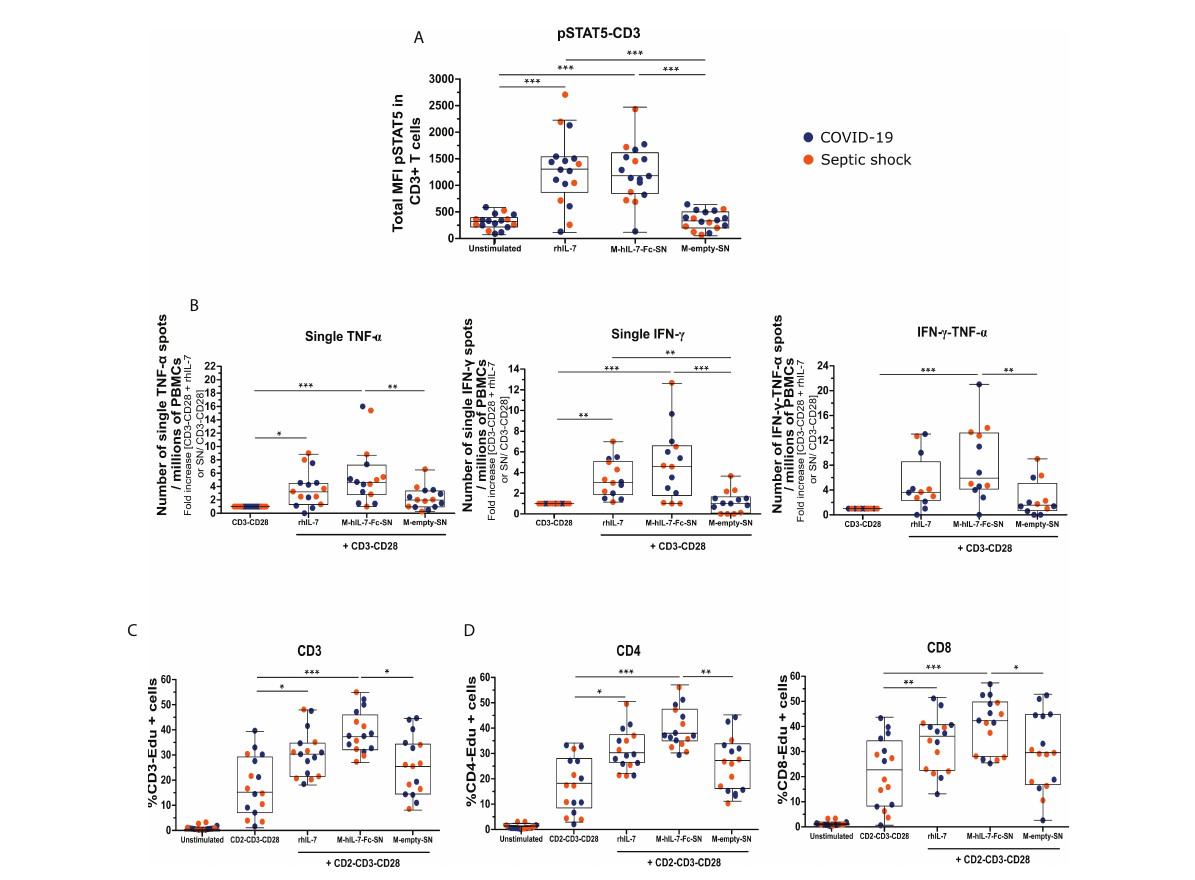
FIGURE 3 The MVA-secreted hIL-7-Fc restores ex vivo T lymphocyte function of patients with septic shock and COVID-19 at day 3 or 4 after ICU admission. (A) Total median of fl uorescence (MFI) of pSTAT5 in CD3+ T cells measured by fl ow cytometry. Whole blood cells of patients with septic shock (n = 6) and COVID-19 (n = 11) were stimulated for 10 min with diluted supernatant from MVA-hIL-7-Fc (M-hIL-7-Fc-SN) and empty MVA (M-empty-SN) infection and rhIL-7 at 100 ng/ml as positive control. (B) Number of single – TNF- a , single – IFN- g , and double – IFN- g – TNF- a spots per millions of PBMCs. PBMCs of patients with septic shock (n = 7) and COVID-19 (n = 8) were stimulated overnight with anti-CD3 and anti-CD28 antibodies (basal condition of cytokine production) in addition to M-hIL-7-Fc-SN or M-empty-SN or rhIL-7 at 100 ng/ml. Number of spots were normalized using the basal condition. Percentage of Edu+ CD3+ T cells (C) and of Edu+ CD4+ or Edu+ CD8+ T cells (D) , measured by fl ow cytometry. PBMCs of patients with septic shock (n = 7) and COVID-19 (n = 9) were stimulated for 3 days using anti – CD2-CD3-CD28 antibody – coated beads (ratio 1:1) in addition to M-hIL-7-Fc-SN or M-empty-SN or rhIL-7 at 100 ng/ml. Data are represented as Tukey box plot. The non-parametric Friedman test followed by Dunn post hoc test for multiple comparisons was performed to compare all the conditions. * p < 0.05, ** p < 0.01, and *** p <